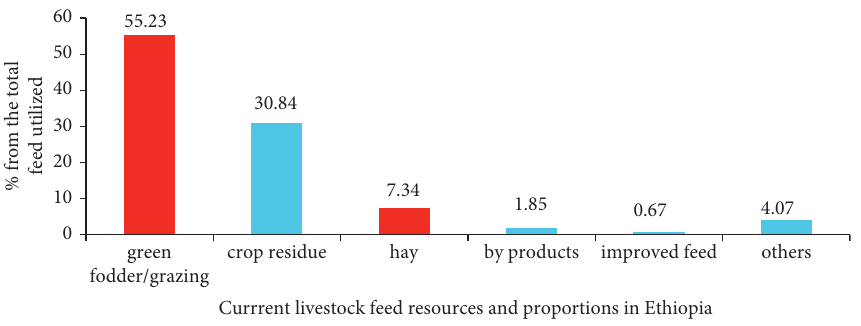
Figure 2: Current livestock feed resources and proportion in Ethiopia. Source: